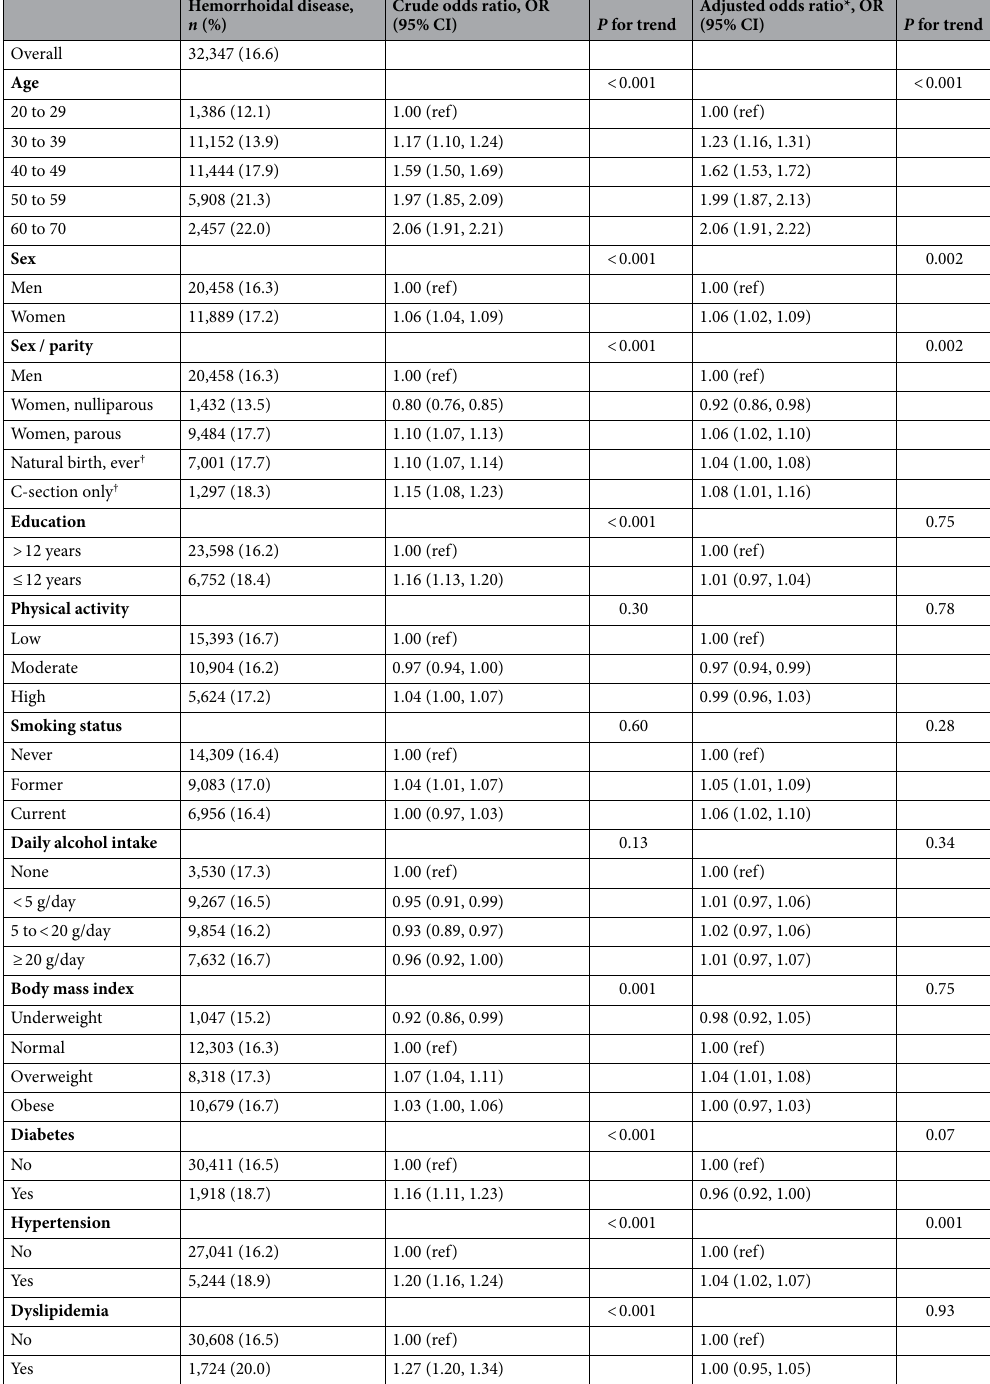
Table 2. Association between participant characteristics and the prevalence of hemorrhoidal disease. * Adjusted for age (20–29, 30–39, 40–49, 50–59, and 60–70 years), sex, year of visit, center, education (≤ 12 and > 12 years), physical activity (low, moderate, and high), smoking (never, former, and current), daily alcohol intake (none, < 5 g/day, 5 to < 20 g/day, and ≥ 20 g/day), BMI category (underweight, normal, overweight, and obese), and presence of diabetes, hypertension, and dyslipidemia. The ORs for sex / parity categories were obtained from a model with the same covariates but replacing sex with sex / parity categories. † Excluding participants without information on the mode of